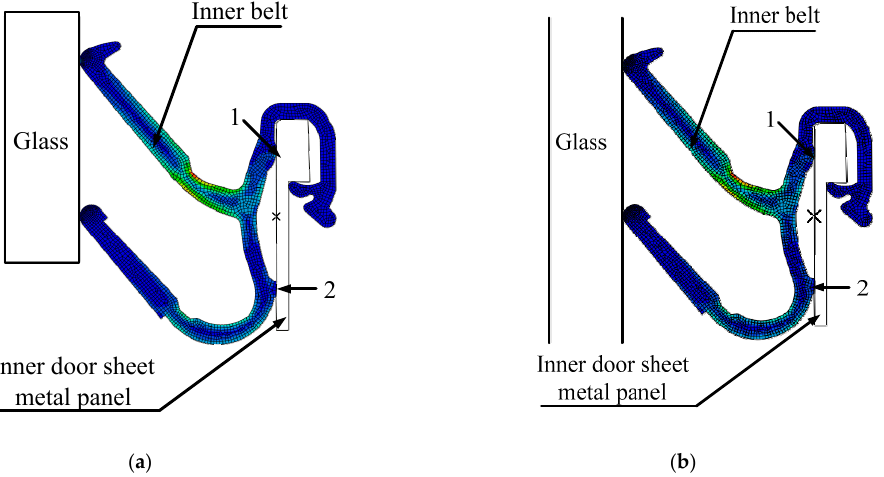
Figure 25. Load carrying cloud diagram of inner belt. ( a ) Stress load at 1 s; ( b ) stress load at 3 s.